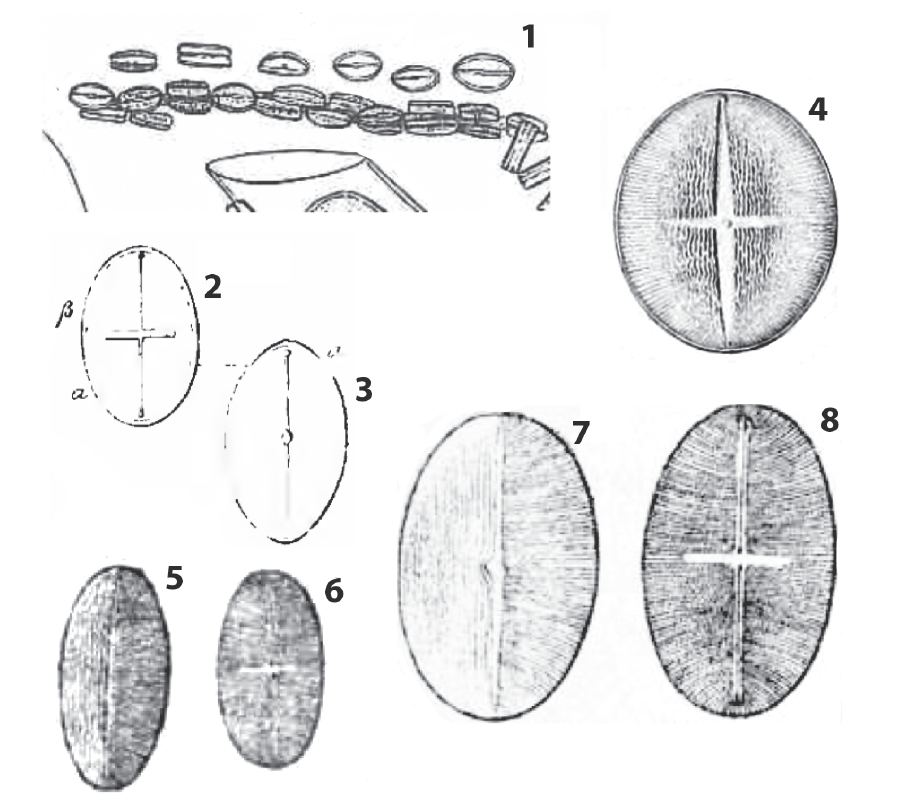
Figs 1–8. Original drawings. 1 . Cocconeis molesta Kütz. (Kützing 1844, pl. 5, fig. 7). 2–3 .